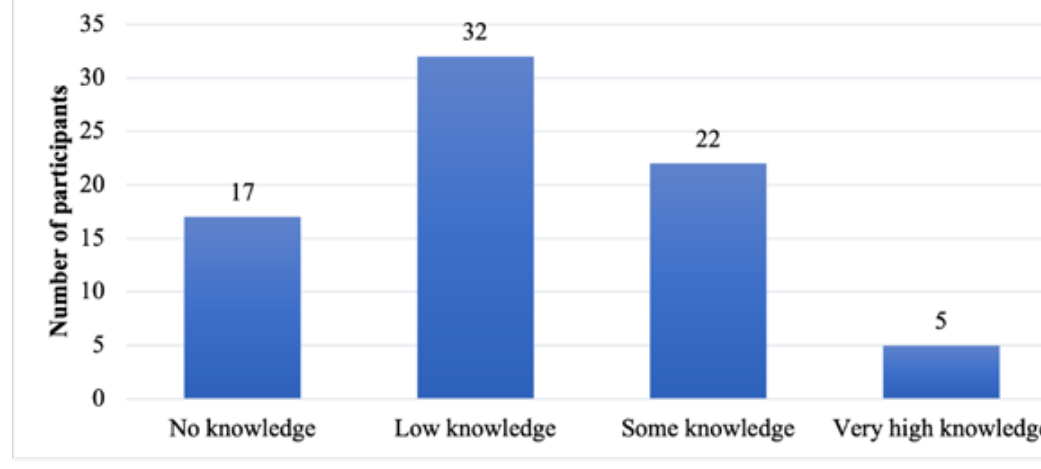
Figure 4. Knowledge of hormonal contraceptives in musculoskeletal